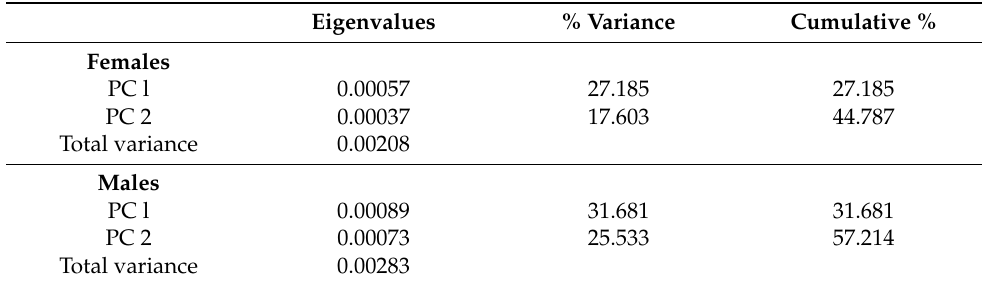
Table 2. Eigenvalues and contribution of principal components (PCs) in the shape variation of Acanthoscelides obtectus females and males.